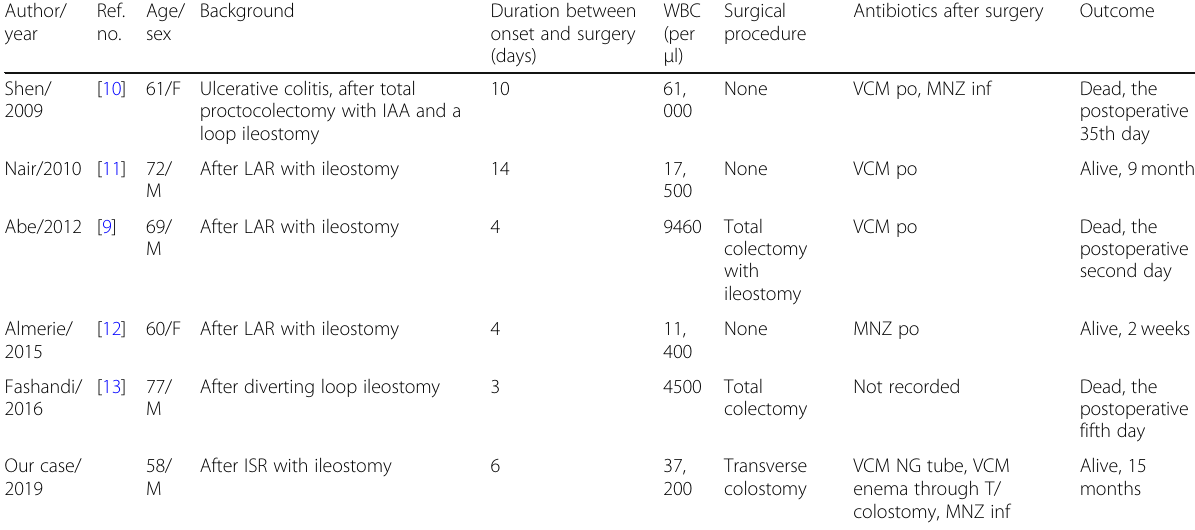
Table 1 CDI reported cases after reversal of